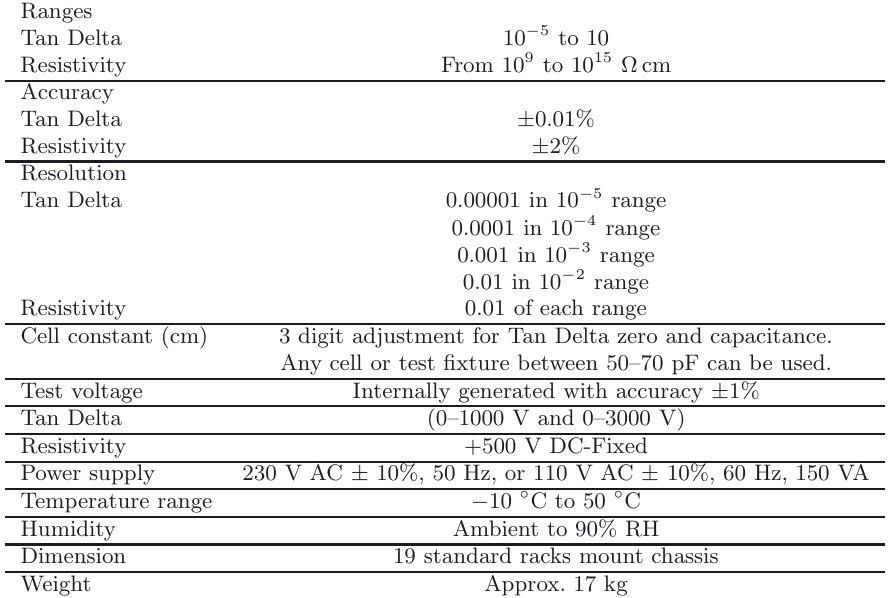
Table 1. Specification of Tan Delta and resistivity set.